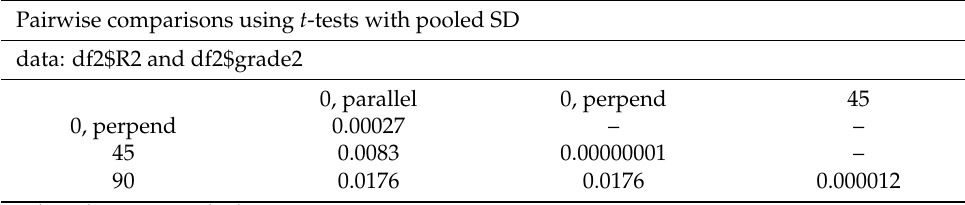
Table 12. Mean value and variance for DETAX